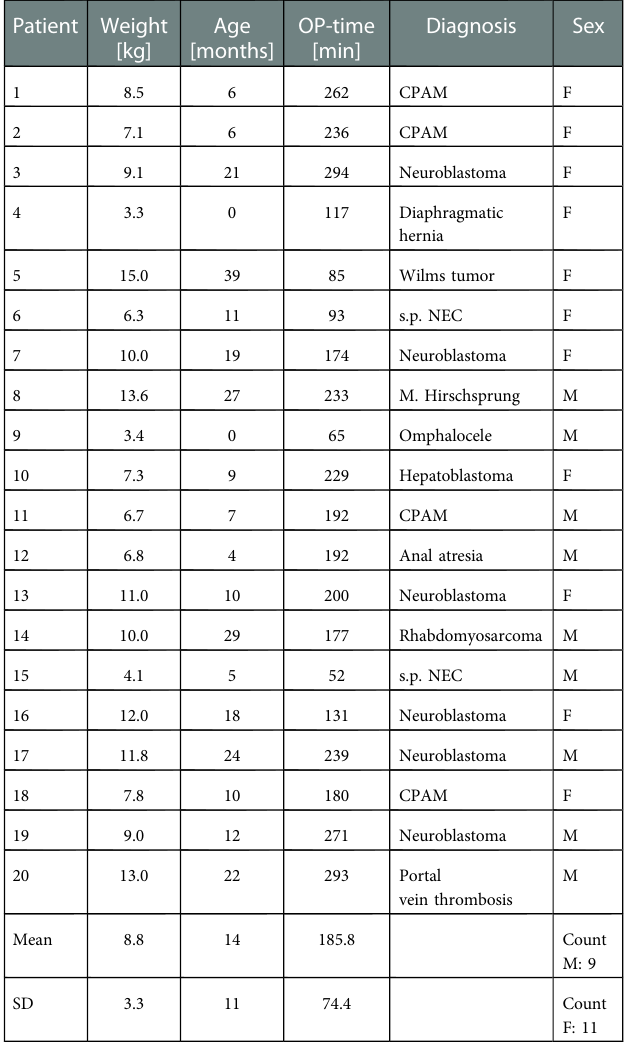
The fi rst column is the patient number which matches with the numbers in the second table. The units of the columns are indicated in [ ]. CPAM, congenital pulmonary airway malformation. NEC, necrotizing